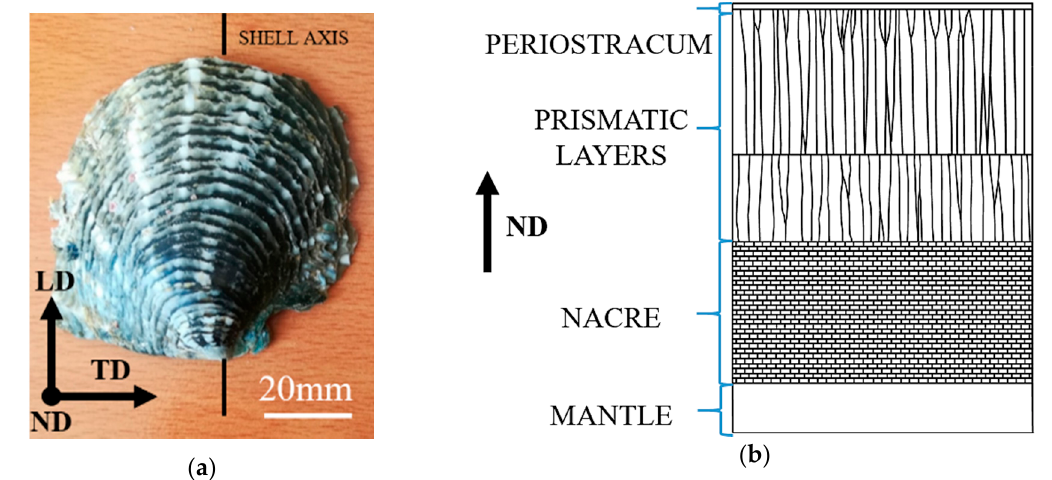
Figure 1. ( a ) Image of the outer surface of the P. margaritifera shell and definition of the directions where LD is the longitudinal direction parallel to shells axis, TD is transverse direction determined by growth lines on shells surface and ND is normal direction, indicating growth direction of the shell perpendicular to the plane defined by LD and TD and ( b ) schematic cross-section through the shell showing the layered